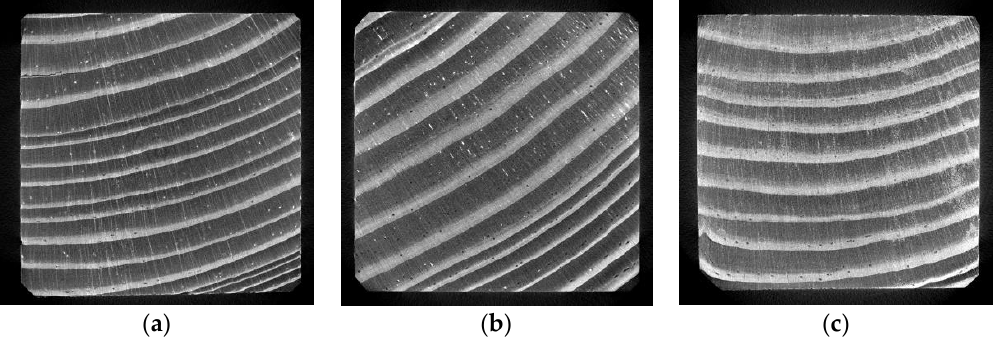
Figure 13. Exemplary cross sections of samples: ( a ) “1”; ( b ) “2”; ( c ) “3” (scale 200%).